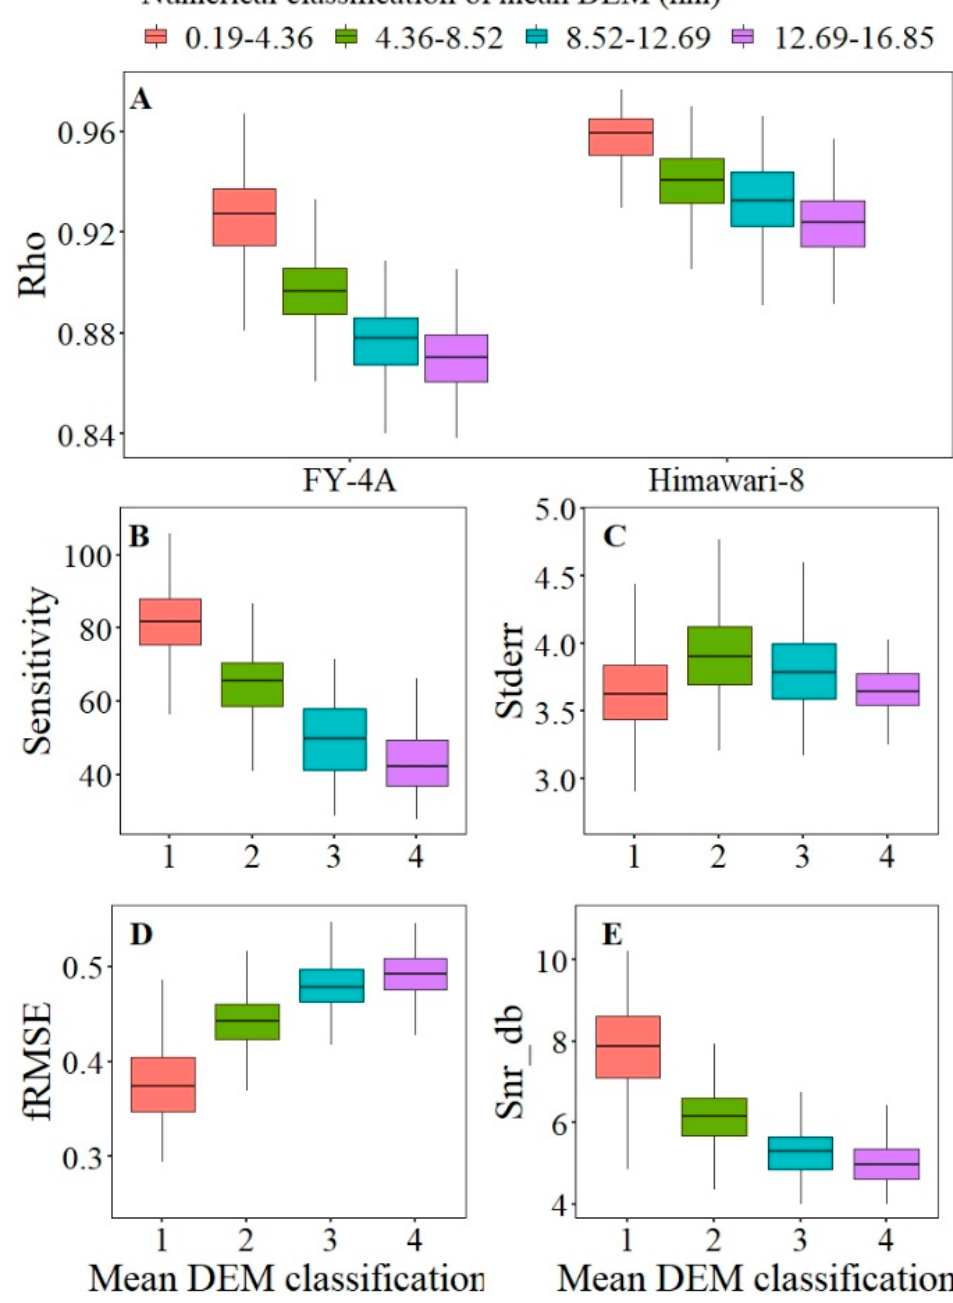
Figure 6. Error indicators of TCA for different mean DEM classifications; ( A ): Rho vs. DEM for LST of FY-4A and Himawari-8; ( B – E ) are Sensitivity, Stderr, fRMSE, and Snr_db vs. DEM for FY-4A LST; the number of FY-4A grids in each mean DEM classification was 7094, 2845, 542 and